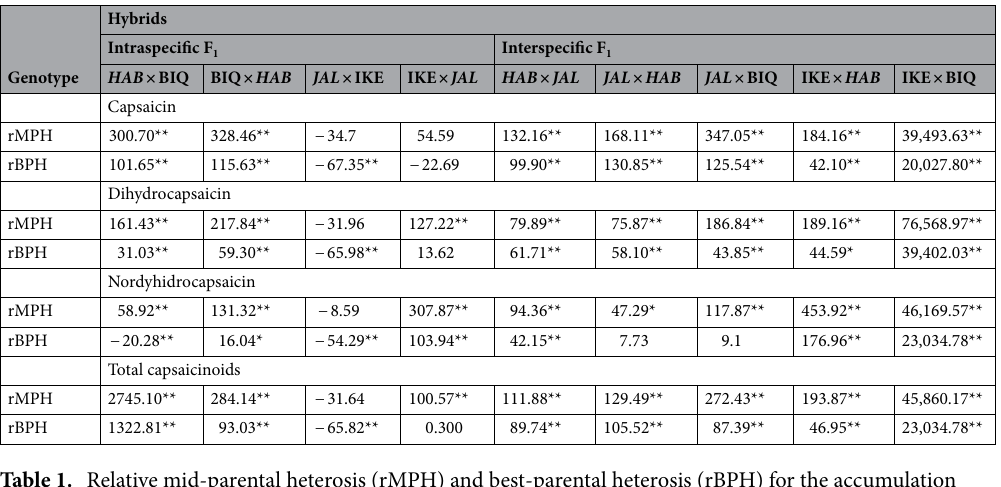
Table 1. Relative mid-parental heterosis (rMPH) and best-parental heterosis (rBPH) for the accumulation of the three main capsaicinoids (capsaicin, dihydrocapsaicin and nordydrocapsacin) and for the total capsaicinoids in the placenta of fully ripe fruits in intraspecific and interspecific hybrids of Capsicum . Parents: C. chinense cv. Habanero (HAB), C. chinense cv. Biquinho (BIQ), C. annuum cv. Jalapeño (JAL) and C. annuum cv. Cascadura Ikeda (IKE). The pungent genotypes are shown in